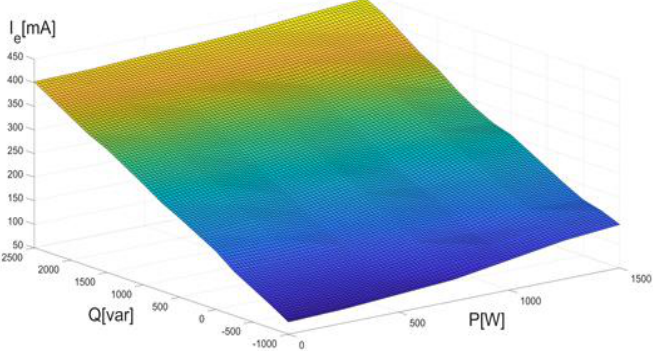
Figure 15. Experimental results. Measured exciter field current ( I e,mea ) for different [P,Q] operating points at the rated output voltage (U = 400 V ) in healthy conditions. points at the rated output voltage (U = 400 V ) in healthy conditions.